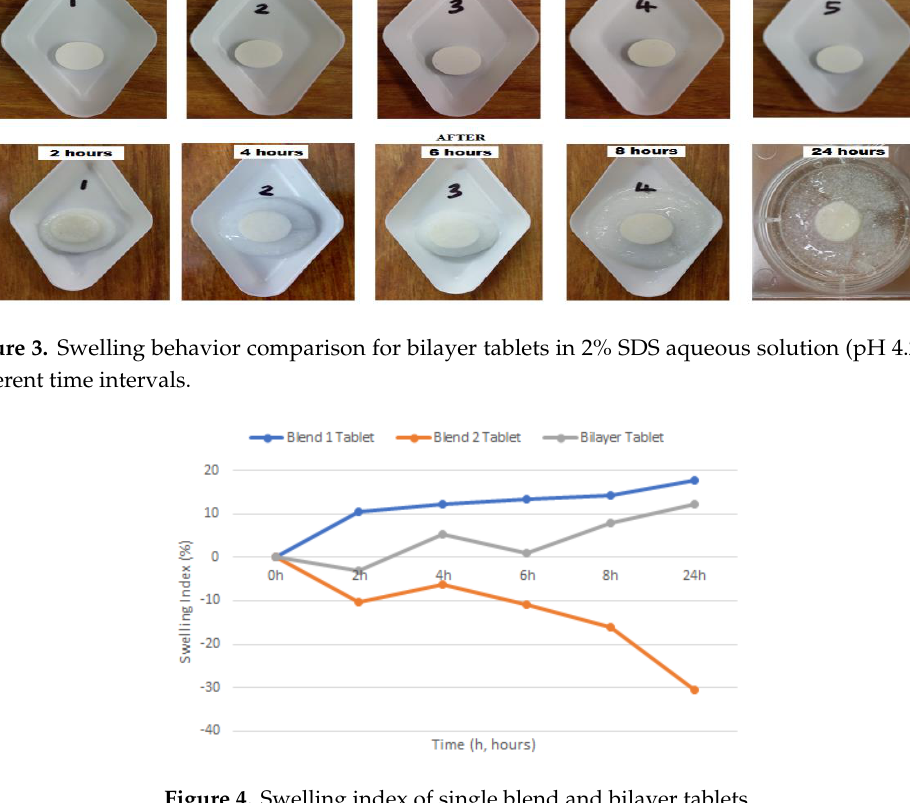
Figure 4. Swelling index of single blend and bilayer tablets.